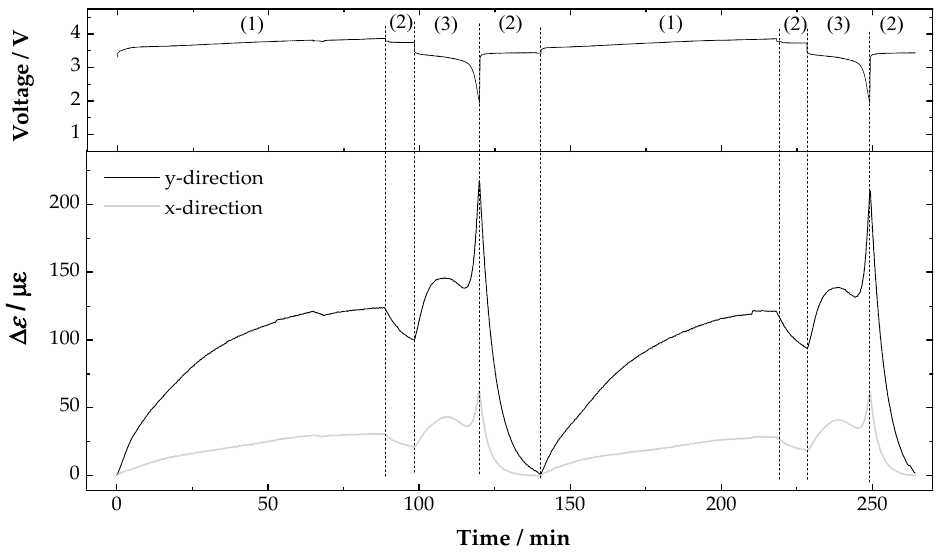
Figure 4. Voltage and strain variations recorded during two cycling tests in the battery in the x - and y -directions. ( 1 ) CC charge; ( 2 ) CV; ( 3 ) CC discharge at 1.32 C.